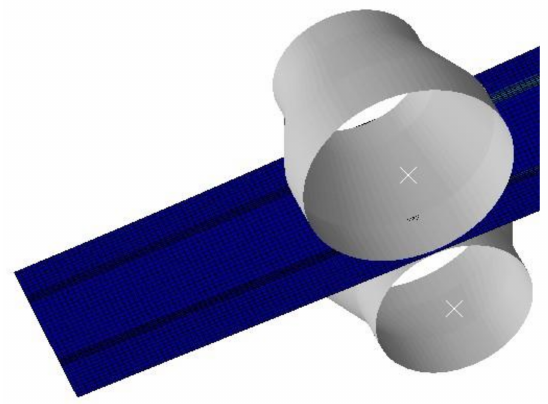
Figure 11. Meshing status.